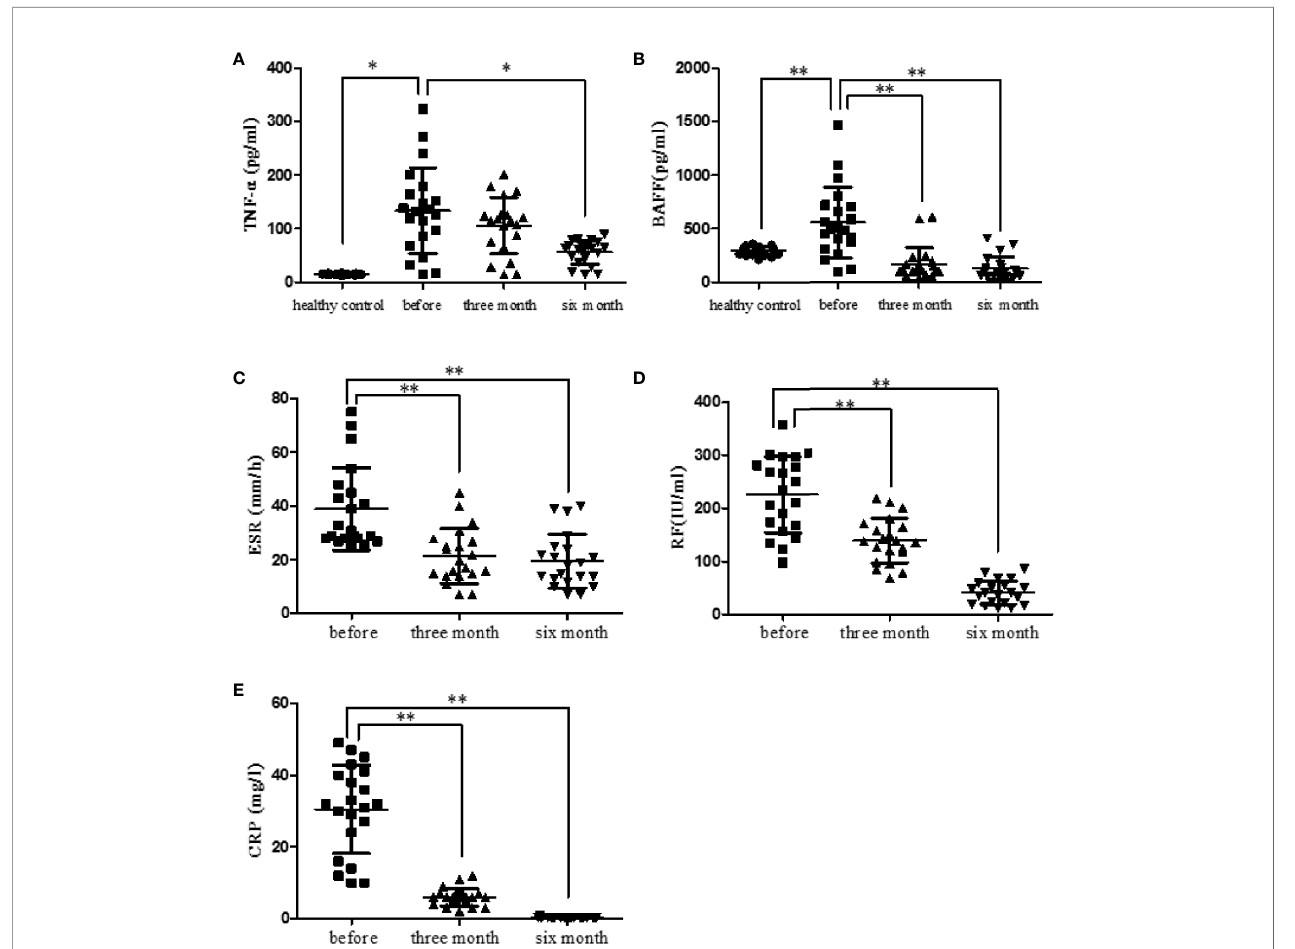
FIGURE 3 | Etanercept down-regulates cytokine levels (TNF- a and BAFF) and laboratory indicators (ESR, CRP, and RF) in patients with RA. (A) The level of TNF- a in healthy people, RA patients, and RA patients treated with etanercept was detected by ELISA. (B) The level of BAFF in healthy people, RA patients, and RA patients treated with etanercept was detected by ELISA. (C) Change in ESR level after etanercept treatment. (D) Change in CRP level after etanercept treatment. (E) Change in RF level after etanercept treatment. * p < 0.05, ** p <